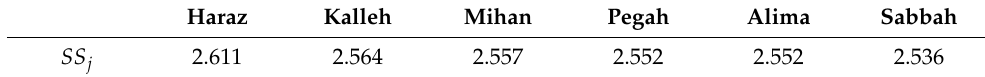
Table 19. The stability scores of the first five selected suppliers derived from Table 6.